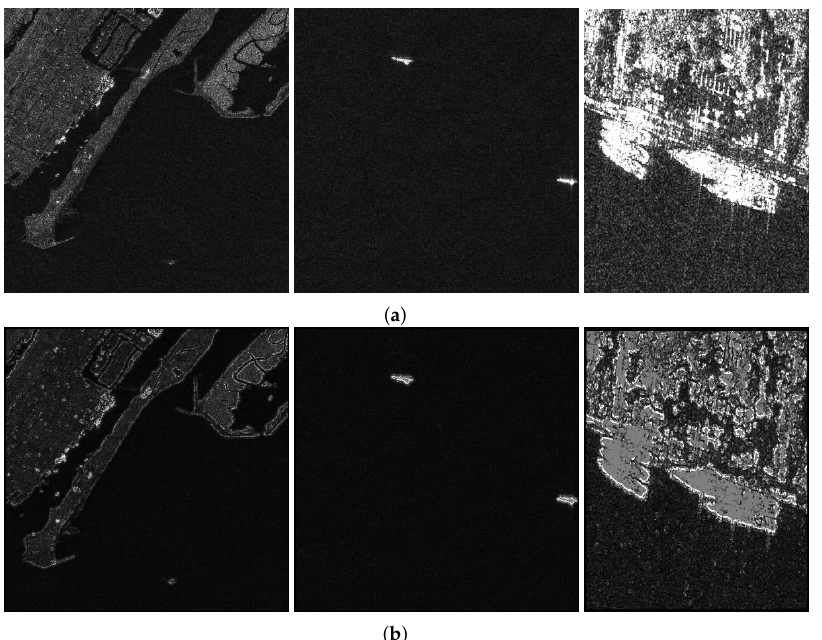
Figure 12. Some of the enhanced results obtained by the SAR image edge enhancement (SEE) module. ( a ) Original input images. ( b ) SEE